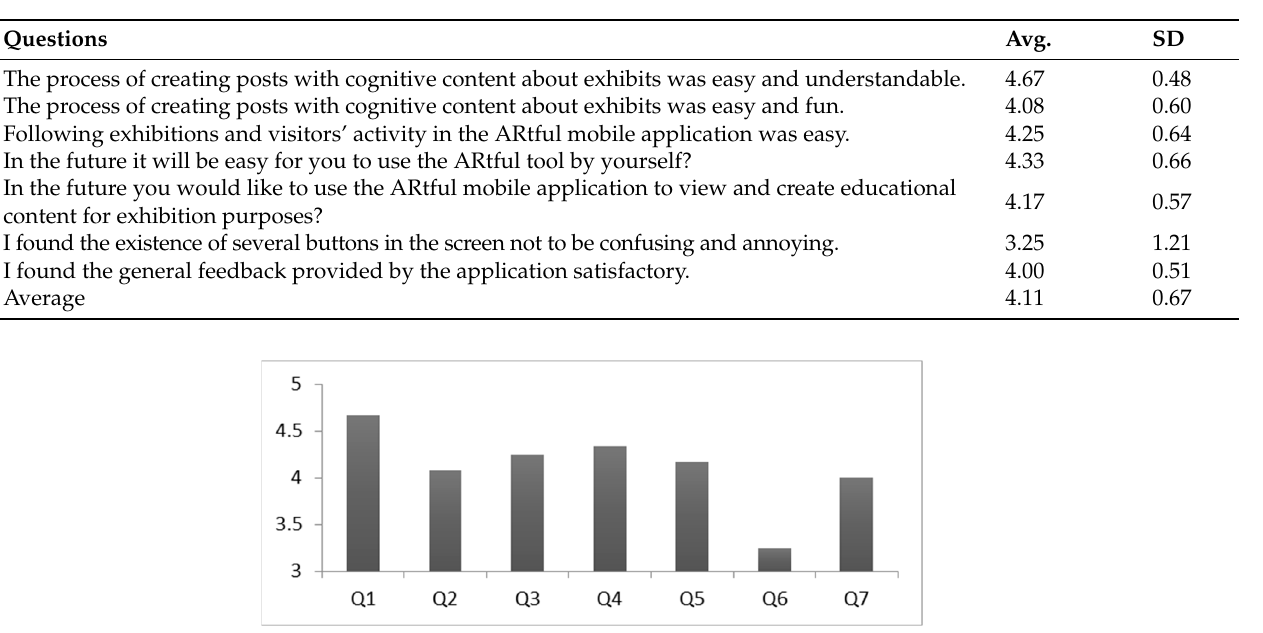
Figure 22. Average ratings of participants’ attitude concerning the usability of the ARtful mobile app.